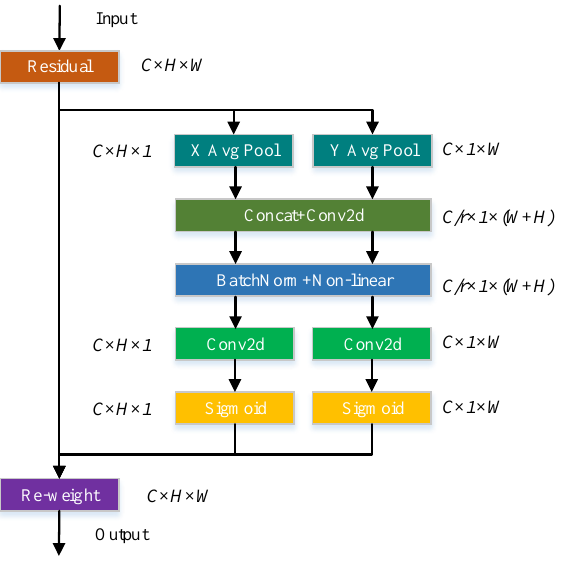
Figure 6. Module of CA.